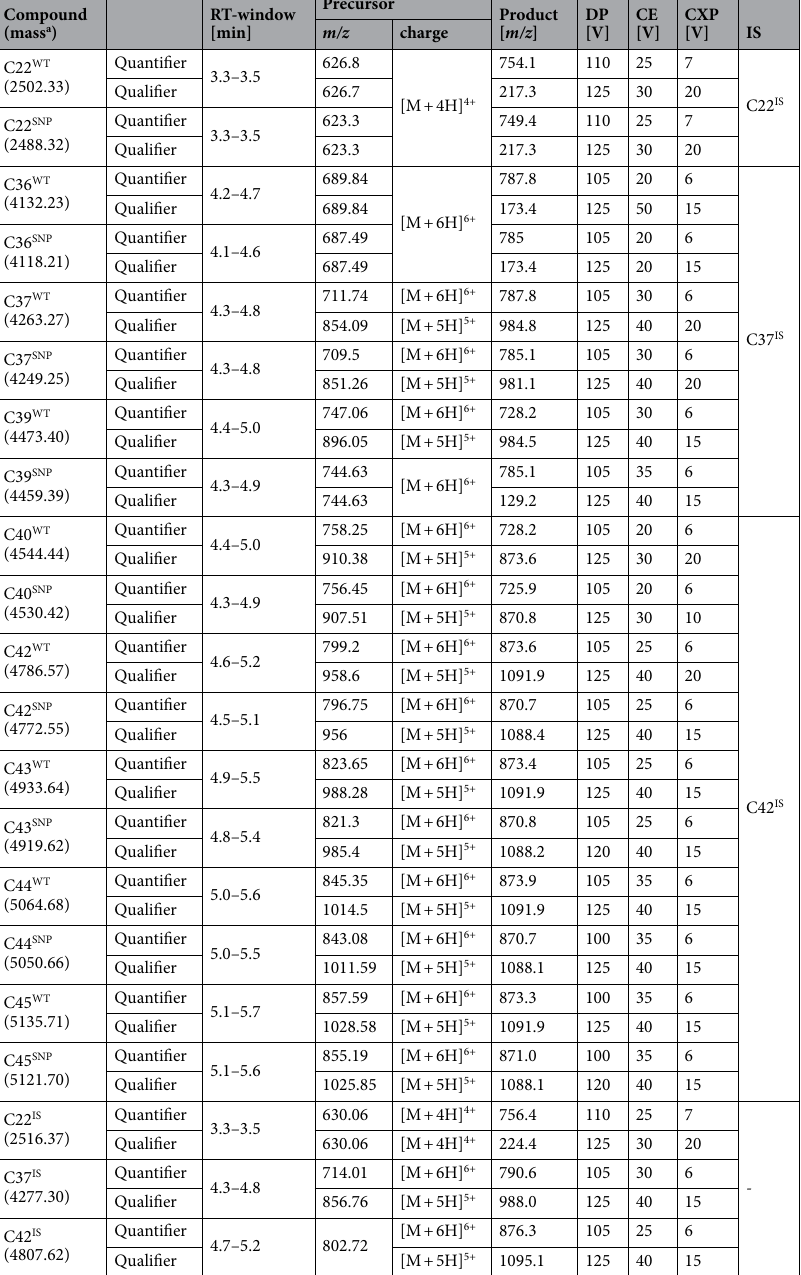
Table 7. Compound-dependent parameters for the detection and quantification of CAAPs. a